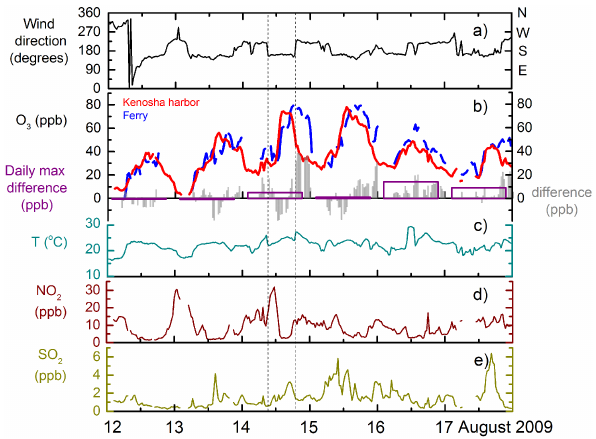
Figure 4. Example period of observations from 12 to 18 August 2009. (a) Wind direction at the Kenosha harbor site; (b) concurrent O 3 observations from Kenosha harbor and Lake Express in transit, their 30min average O 3 (ferry) − O 3 (Kenosha harbor) difference and daily max difference (c) temperature at Kenosha harbor in Cel- sius (d) NO 2 observations from Kenosha harbor and (e) SO 2 obser- vations from Kenosha harbor.